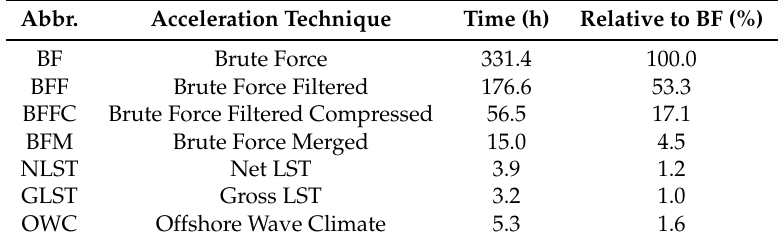
Table 1. Computational times for all considered acceleration techniques; computational times presented as hours run time to compute bed level changes after one